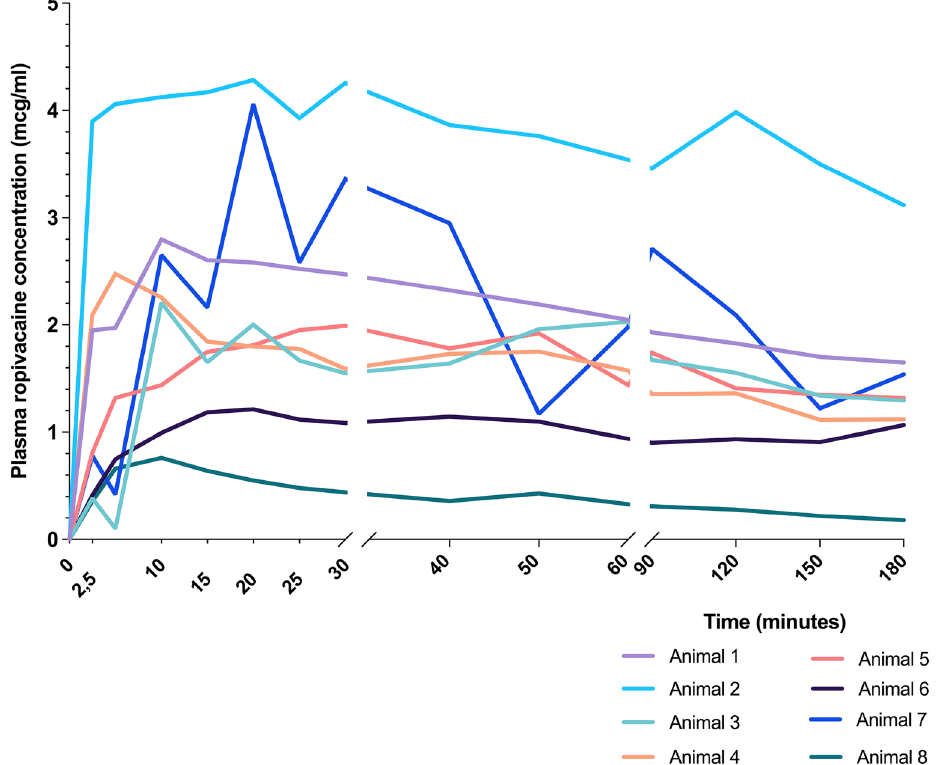
Figure 3. Individual arterial plasma concentration of